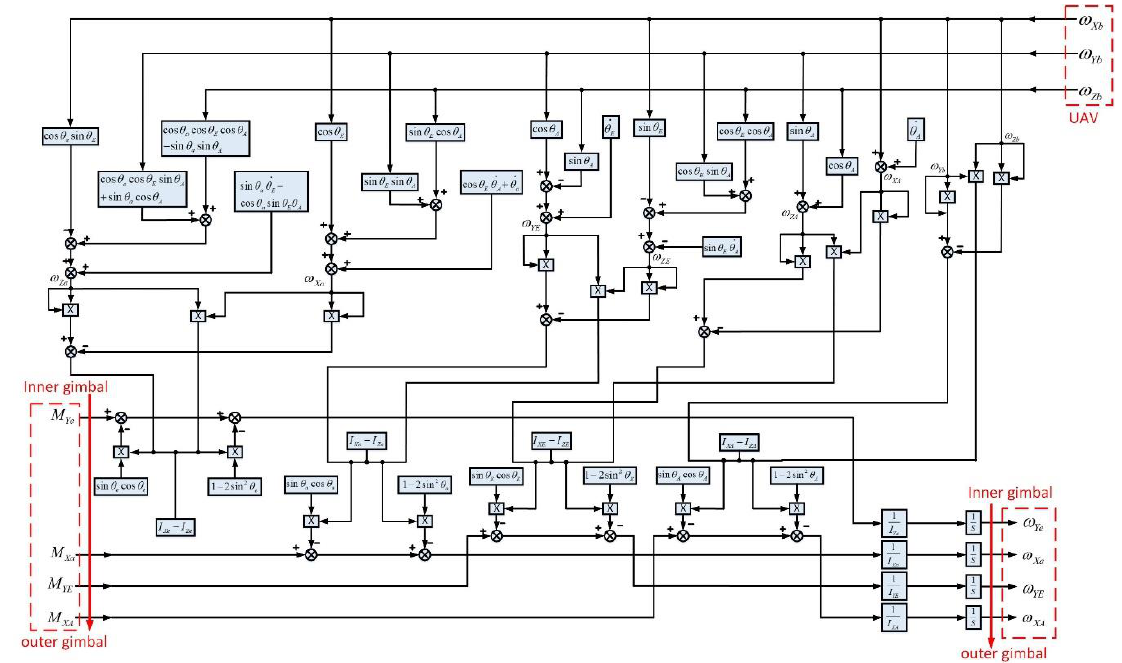
Figure 14. The kinematics coupling relationship of the two-axis four-gimbal electro-optical pod.